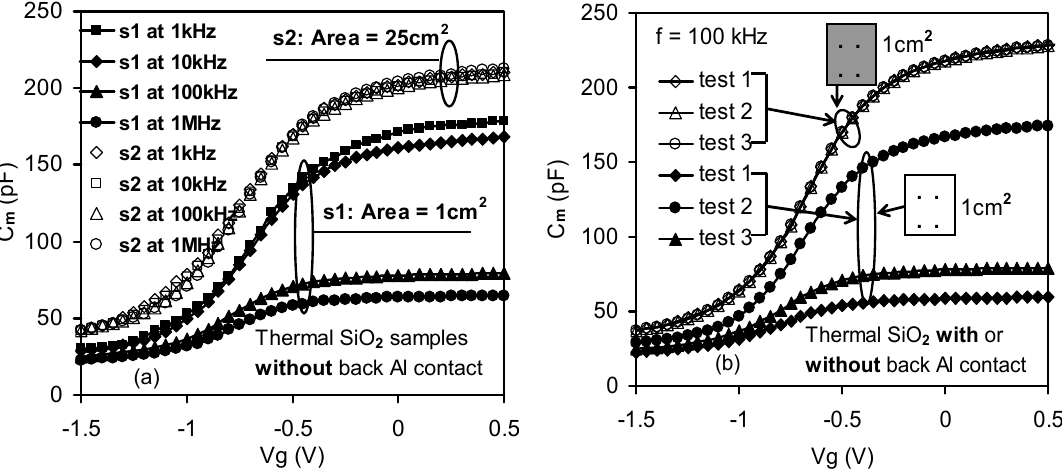
Figure 7. Frequency dispersion in C-V measurements observed in thermal oxide (SiO samples. ( a ) In the absence of substrate back Al contact, dispersion was evident only in the sample with a smaller substrate area (denoted by s1); ( b ) The reproducibility of the tested devices in both the presence and absence of back metal contact. Both of the sample sets were measured three times within 24 hours. Closed symbols (e.g., ▲ ) signified the C-V results from the sample without back Al contact (indicated by a blank square), while the opened symbols (e.g., ○ ) showed the C-V results from the other sample with back Al contact (indicated by a shadow square)